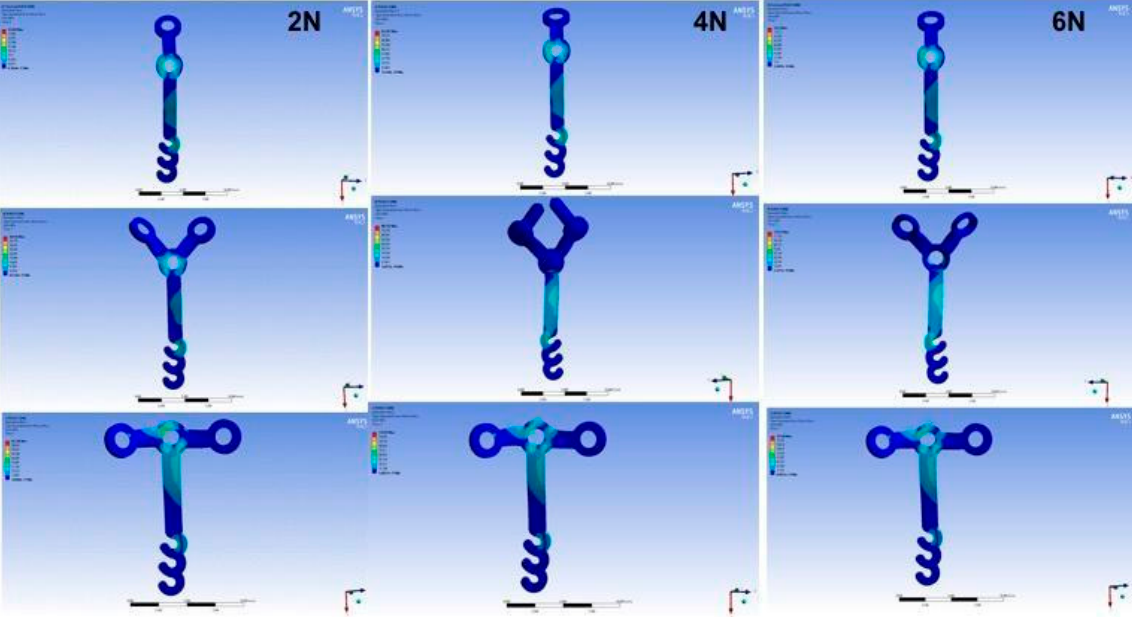
Figure 8. Maximum principal stress was obtained for each type of miniplate (I, Y, and T).